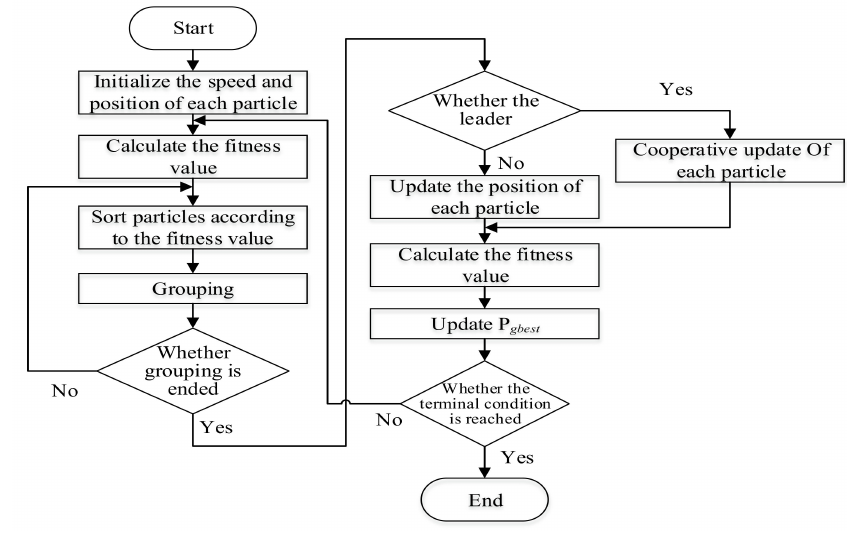
Figure 2. Flowchart of dynamic group cooperative particle swarm optimization (DGCPSO).